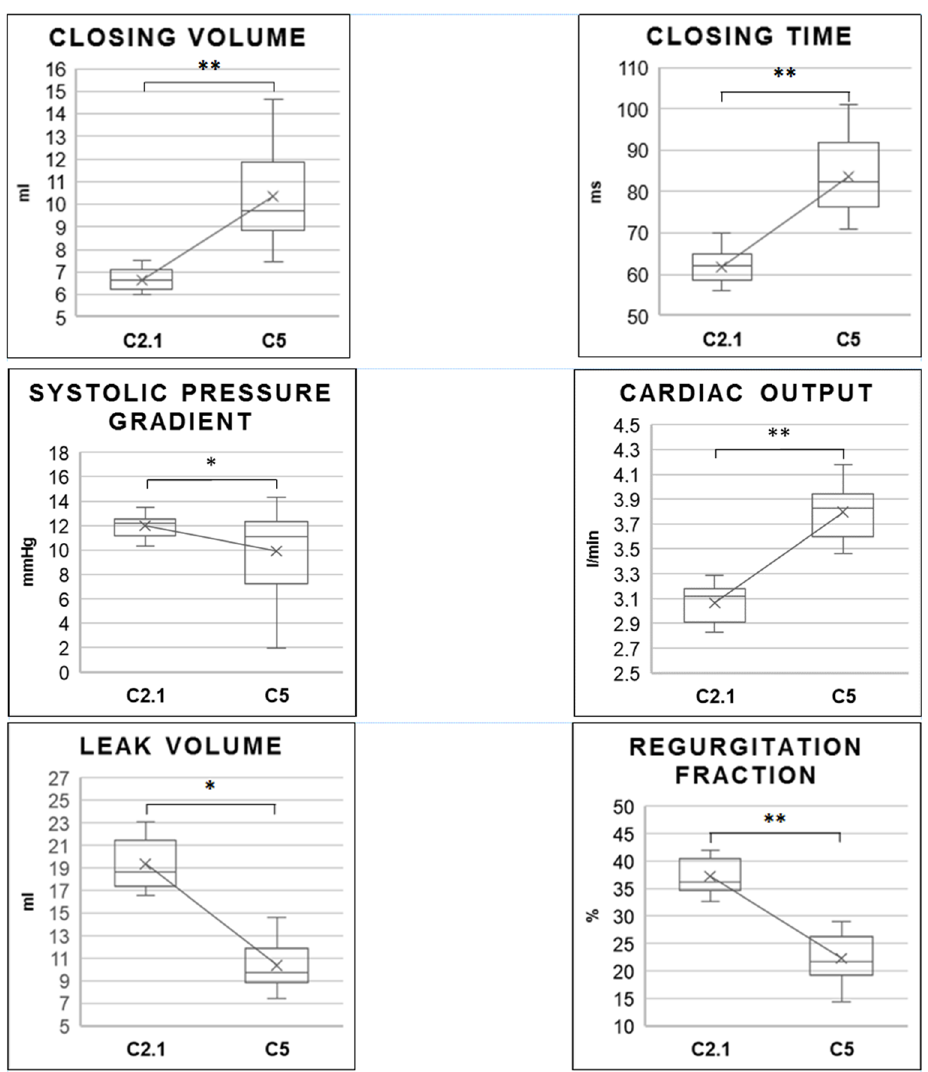
Figure 3. Comparison of the performance of the best-performing prototype with a solid stabilization structure (C2.1) and the last (C5) prototype with additional “inner leaflets” after removal of this structure. * p < 0.05; ** p < 0.001 . Table 1. Performance characteristics of the presented prototypes. For comparison, values are given for a biological (Edwards Perimount 23 mm) and mechanical prosthesis (Medtronic Advantage 23 mm) within our measurement setup.